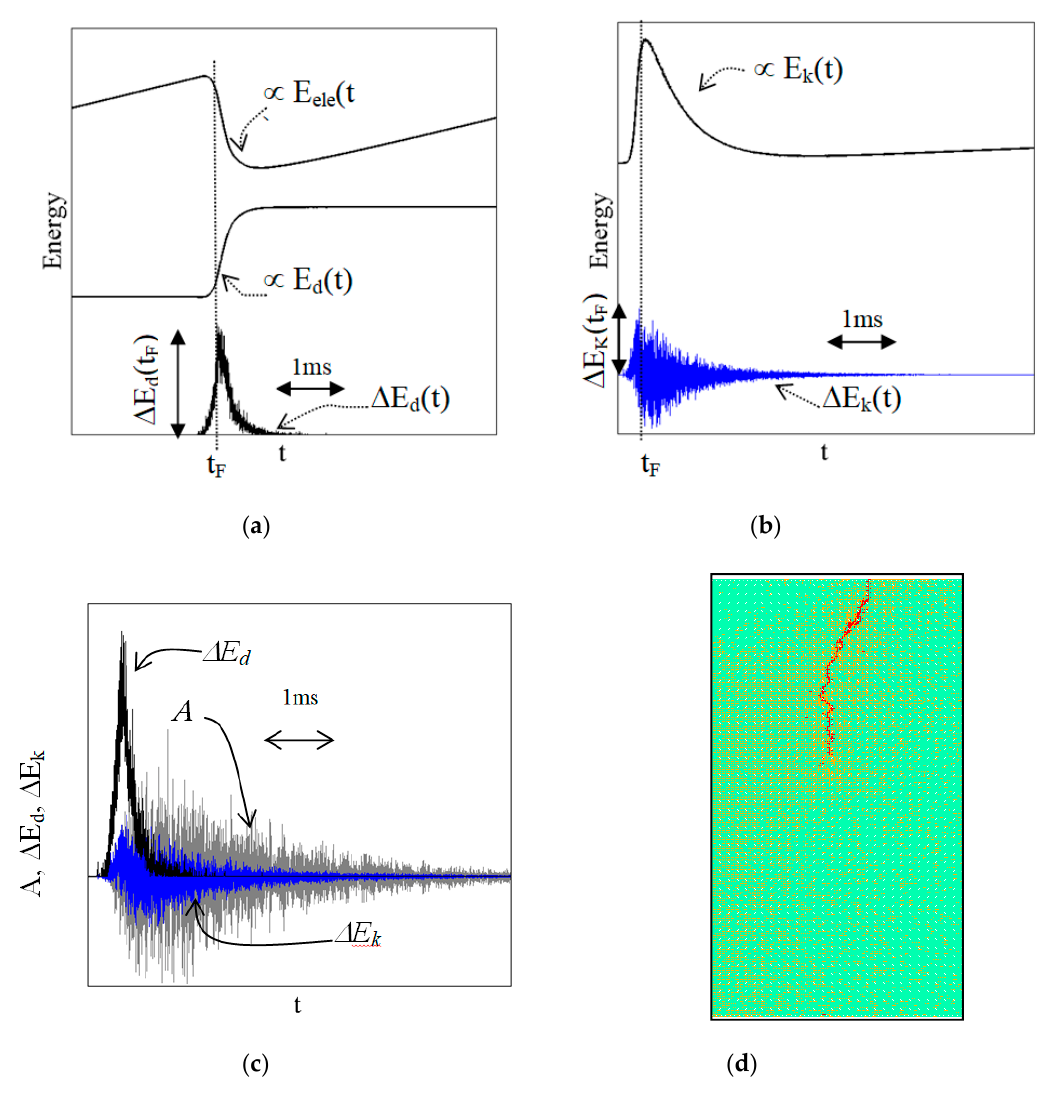
Figure 21. Information about the acoustic generic emission events simulated: when a typical event happened: ( a ) dissipated energy increments Ed and its Ed evolution during the process simulated. ( b ) Kinetic energy Ek and the evolution of its increment Ek during the process simulated. ( c ) The typical acoustic emission event, A shows by means of the acceleration captured by a sensor (gray line), the Ek and Ed evolution during the process simulated. ( d ) Detail of a typical fissure propagation simulated with the numerical model used (figure edited from [59]).